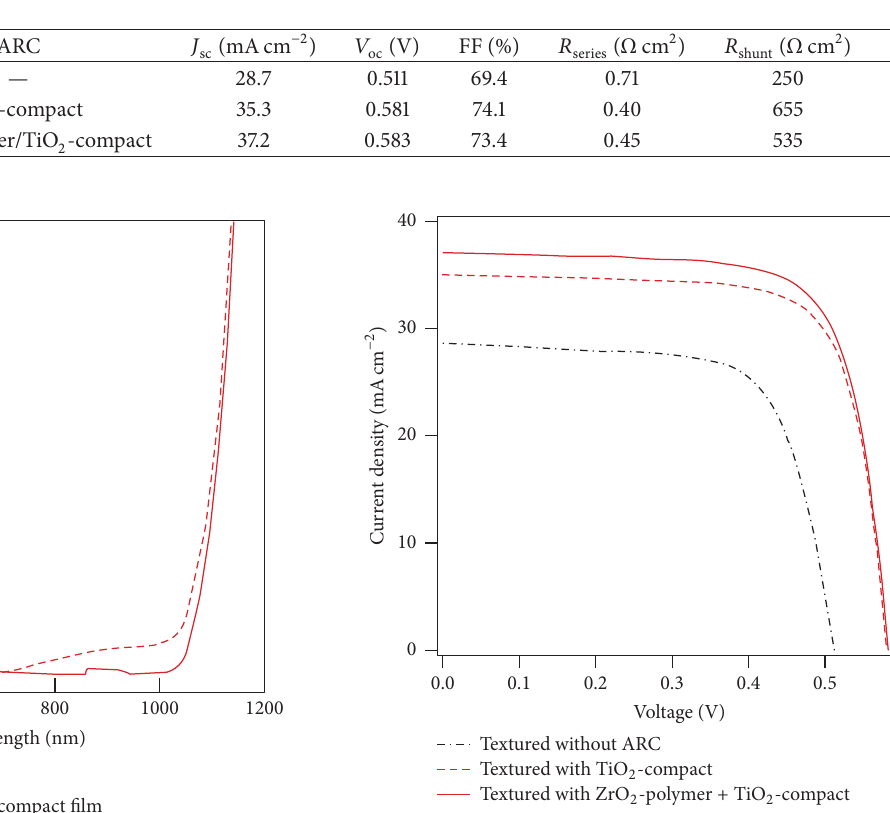
Figure 2: Comparison of the reflectivity of the textured silicon wafers with TiO 2 single layer and spin-coated ZrO 2 /spray-deposited TiO 2 double layer.